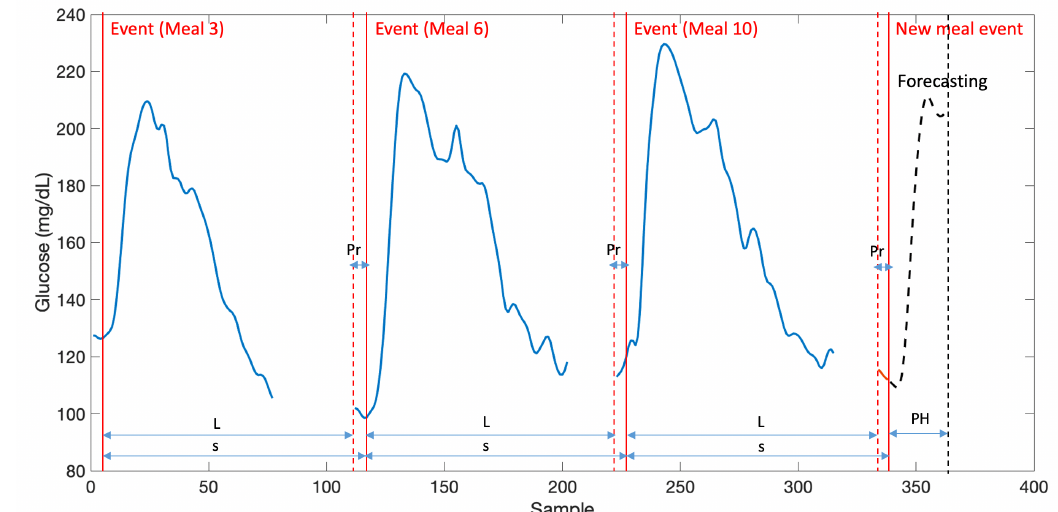
Figure 1. An illustrative example of a concatenated time series for seasonal stochastic local models identification. Each element in a cluster, corresponding in this case to glucose responses to meal events regularized to length L , are concatenated ordered according to the event time stamp, and preceded by pre-sampling data of length P r . As a result, a seasonal time series with seasonality s = L + P r is obtained. Remark that meal events not necessarily are consecutive due to the clustering